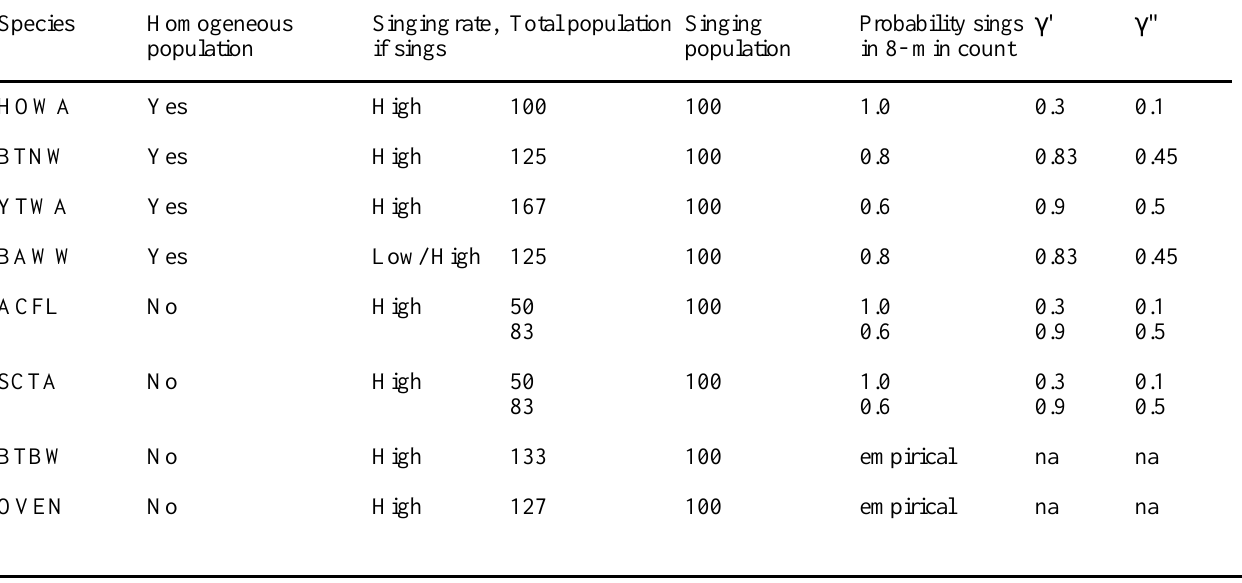
Table 1. Experimental conditions for each of the eight species of interest. The first four species were homogeneous in population structure, in that all birds had the same probability of calling in each interval, whereas the next four species were heterogeneous. All species except the BAWW had a high singing rate per interval. Total and Singing Population sizes are presented as the probability of singing during the 8- min count. The last two columns summarize the Markovian nature of the singing process and are explained in detail in the